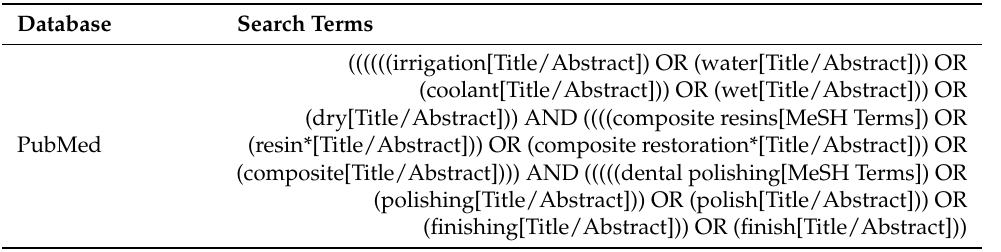
Table 2. Search terms used in each one of the